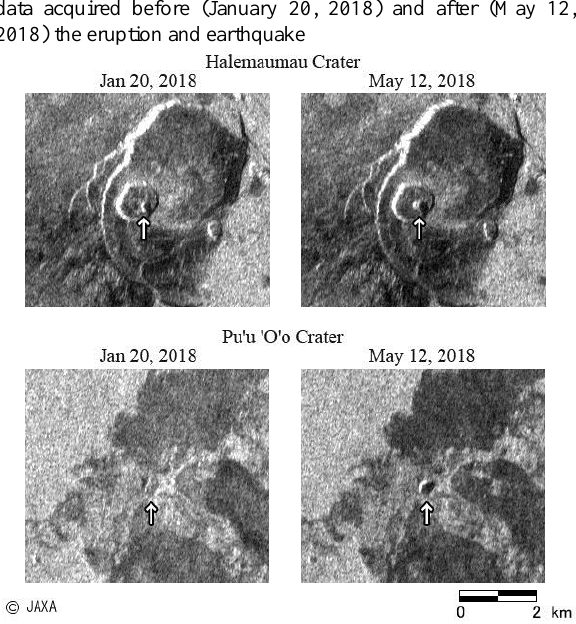
Figure 3. Comparison of the two HH amplitude images acquired before (Jan. 20, 2018) and after (May 12, 2018) the eruption